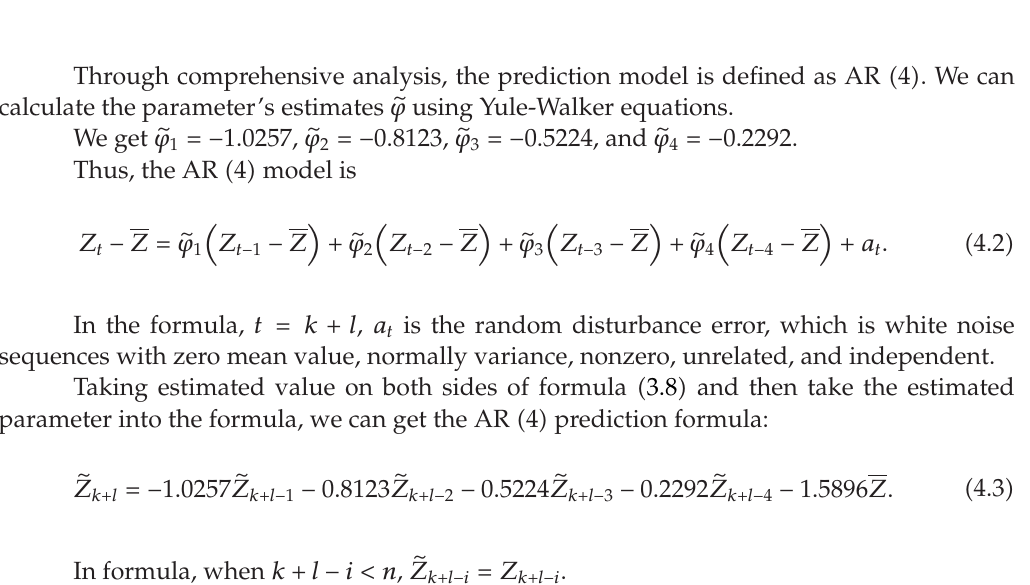
Figure 9: Comparison of predicted value and actual inspection data in late June